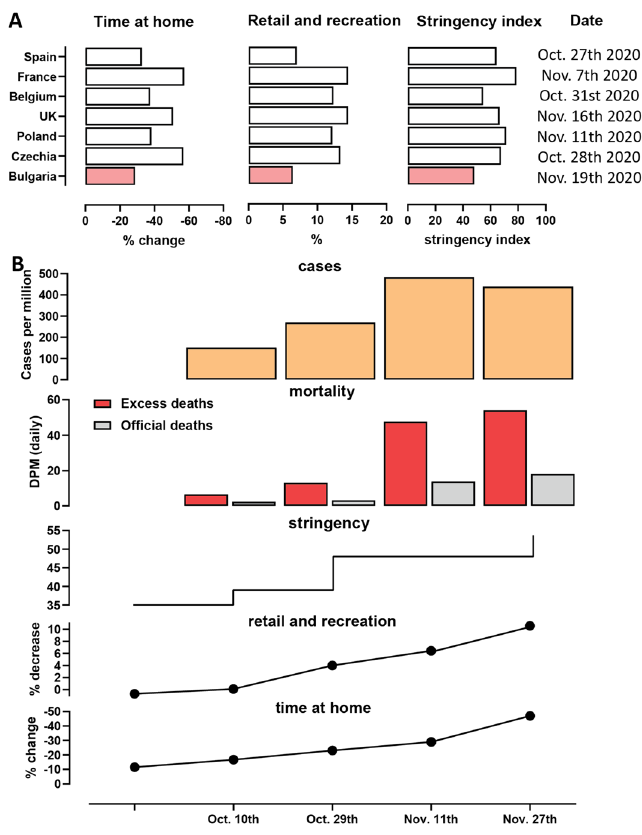
Figure 8. Mobility metrics, stringency of restrictions and mortality and cases at the peak of the late-2020 wave in Bulgaria. ( A ) Google Mobility Data and Stringency Index at the peak of the fall wave in Bulgaria and other EU countries. “Time Home” refers to the change of the number of visitors to residential areas relative to the period before the pandemic. “Time Retail and Recreation” refers to the change of the number of visitors to places of retail and recreation relative to the period before the pandemic. This includes restaurants, cafes, shopping centers, theme parks, museums, movie theatres, libraries. ( B ) Timeline of imposition of